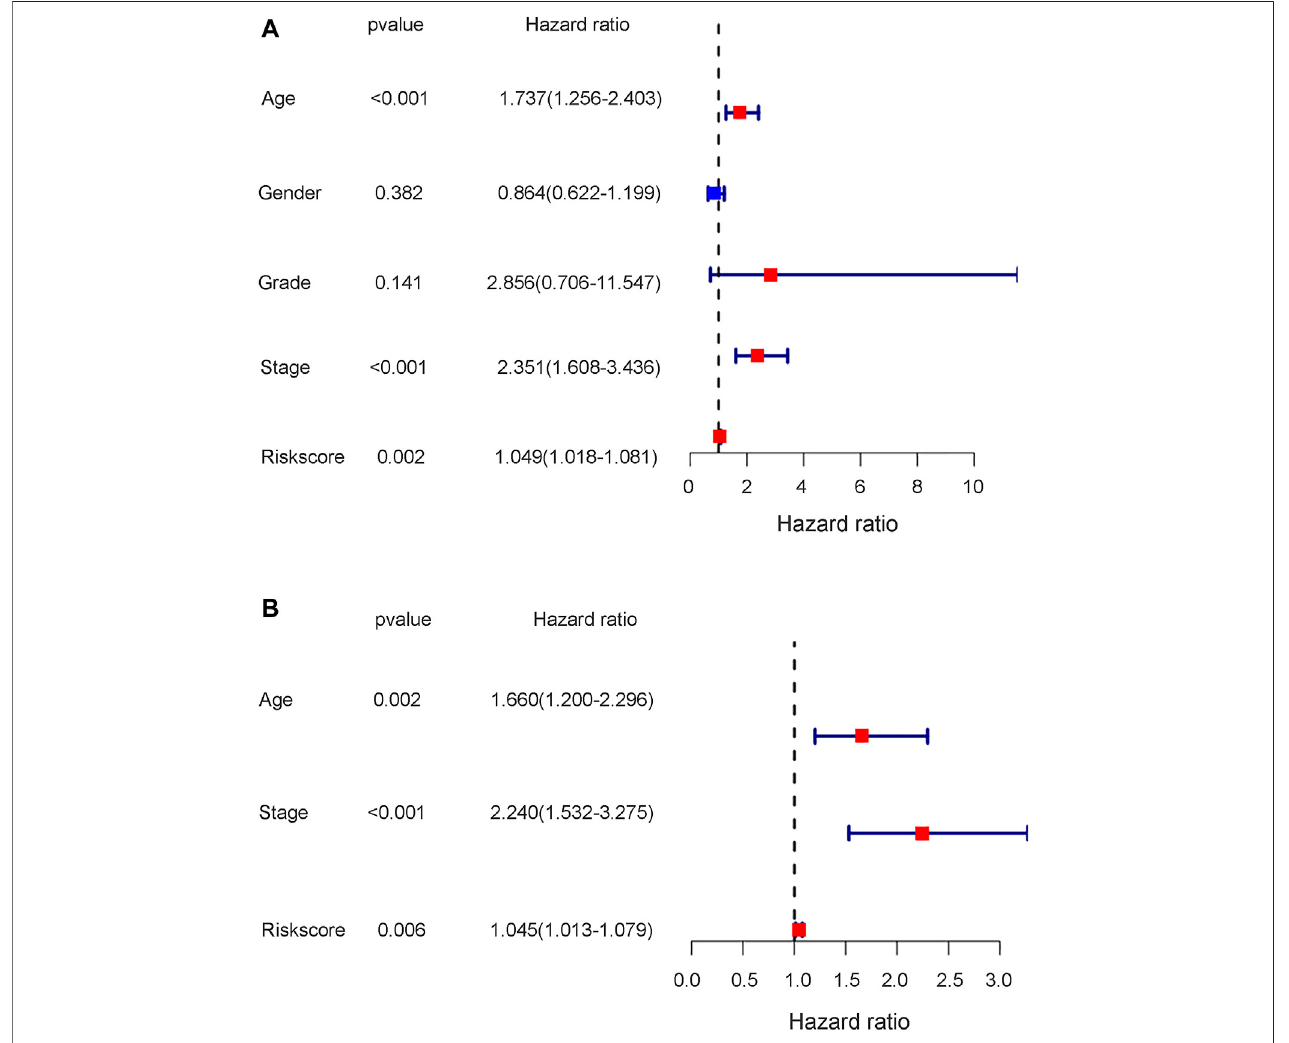
FIGURE 8 | The results of univariate and multivariate cox regression analysis in TCGA cohort. (A) The univariate cox regression analysis in TCGA cohort. (B) The multivariate cox regression analysis in TCGA